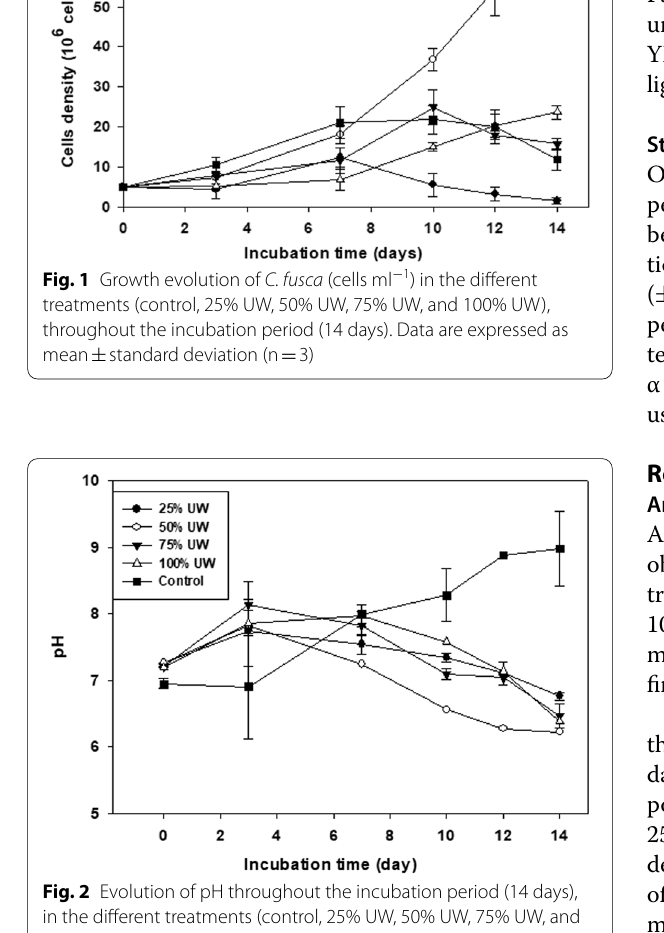
standard deviation (n ± =